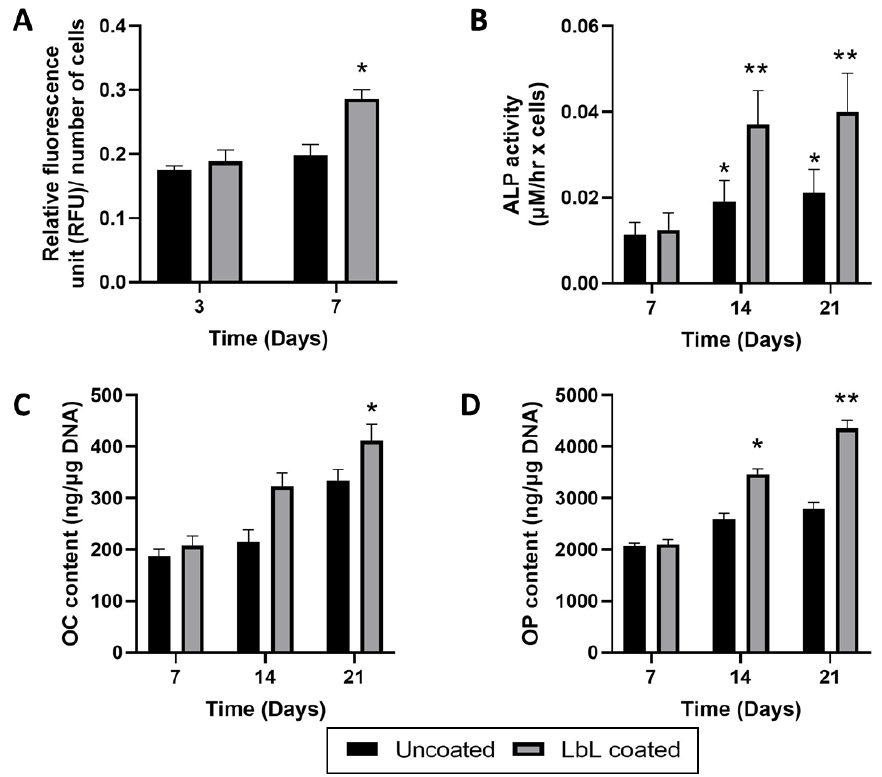
Figure 4. In vitro cell tests. ( A ) Y201 metabolic activity (PrestoBlue ® assay) after culturing for 3 and 7 days. ( B ) Alkaline phosphatase activity, ( C ) Osteopontin protein content and ( D ) Osteocalcin protein content of Y201 at 7, 14 and 21 days. Statistics: * p < 0.05 and ** p < 0.001.